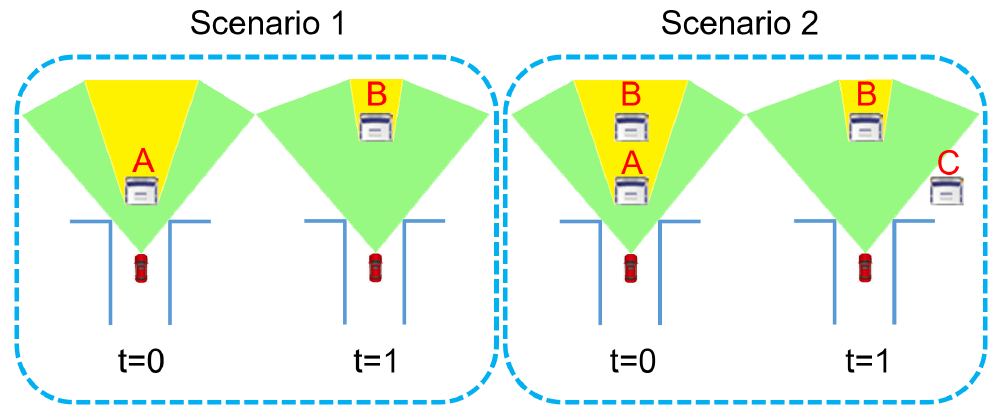
Figure 5. Two possible explanations for Case 3. In Scenario 1, the object in front of the SDV (shown as the red car) is indeed a moving object that moves from A ( t = 0) to B ( t = 1). In Scenario 2, the object ahead moves from A ( t = 0) to C ( t = 1), and the object at location B is a stationary object. From the above analysis, we show that only Case 2 is a strong motion